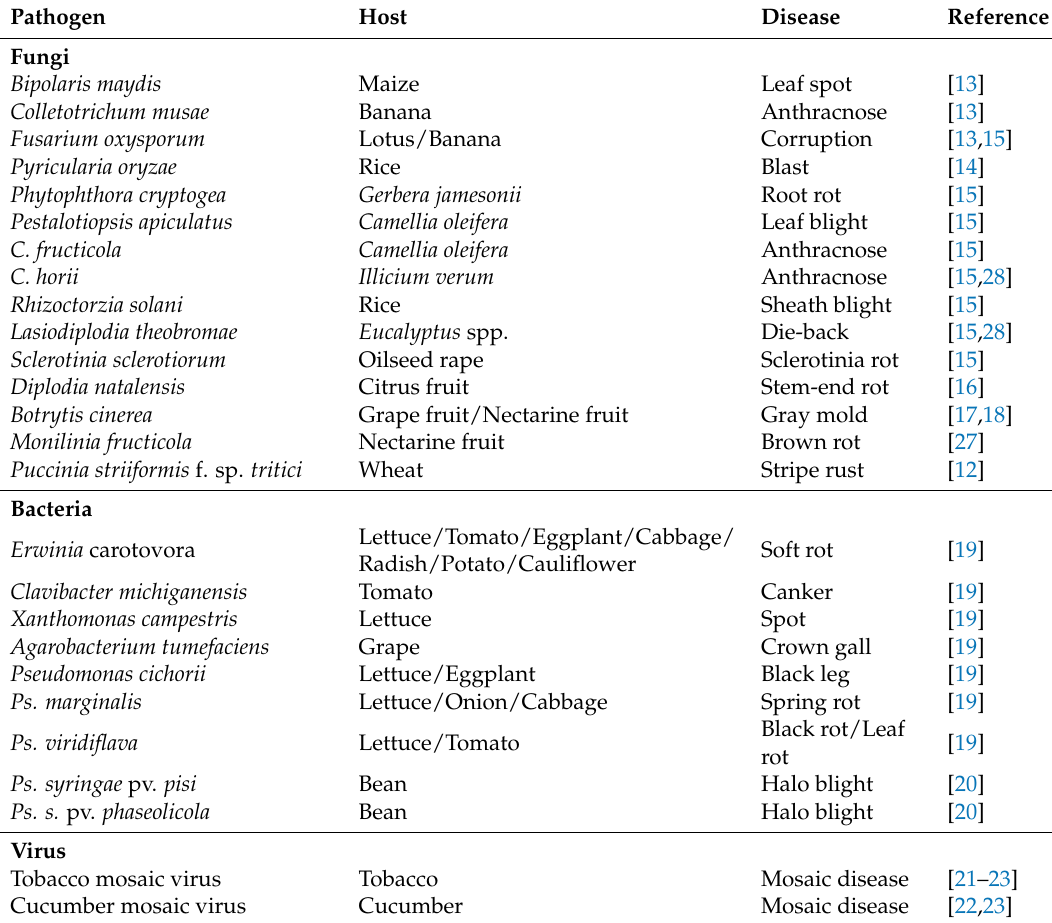
Table 1. Summary of studies of tea polyphenol against